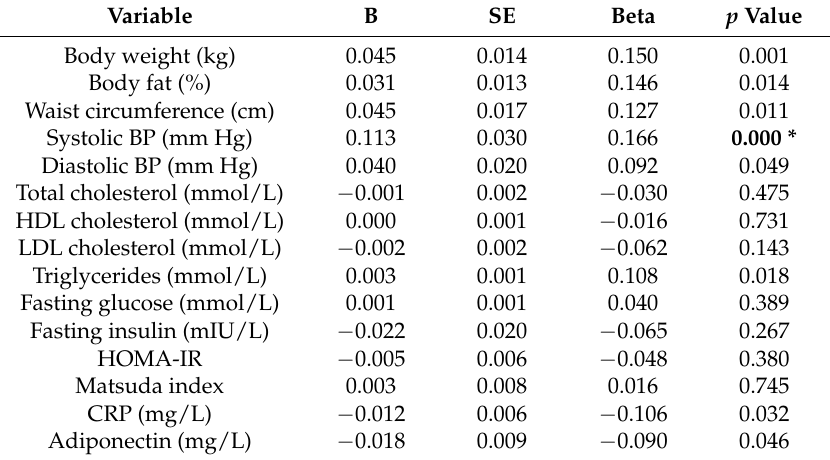
Table 5. Regression coefficients (B), their standard error (SE) and the standardized regression coefficients (Beta) for the associations between cereal protein intake (% of total plant protein intake) and changes in anthropometric variables, blood pressure and metabolic factors during the weight maintenance phase 1